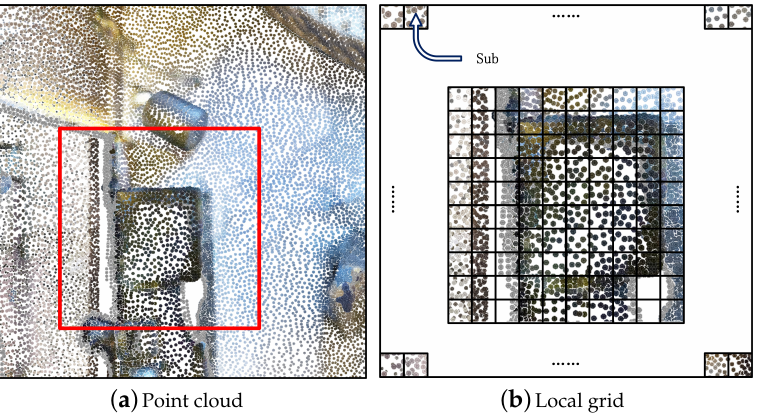
Figure 4. ( a ) is the spatial 3D pointcloud; ( b ) is the mapping of the pointcloud information in the local grid.